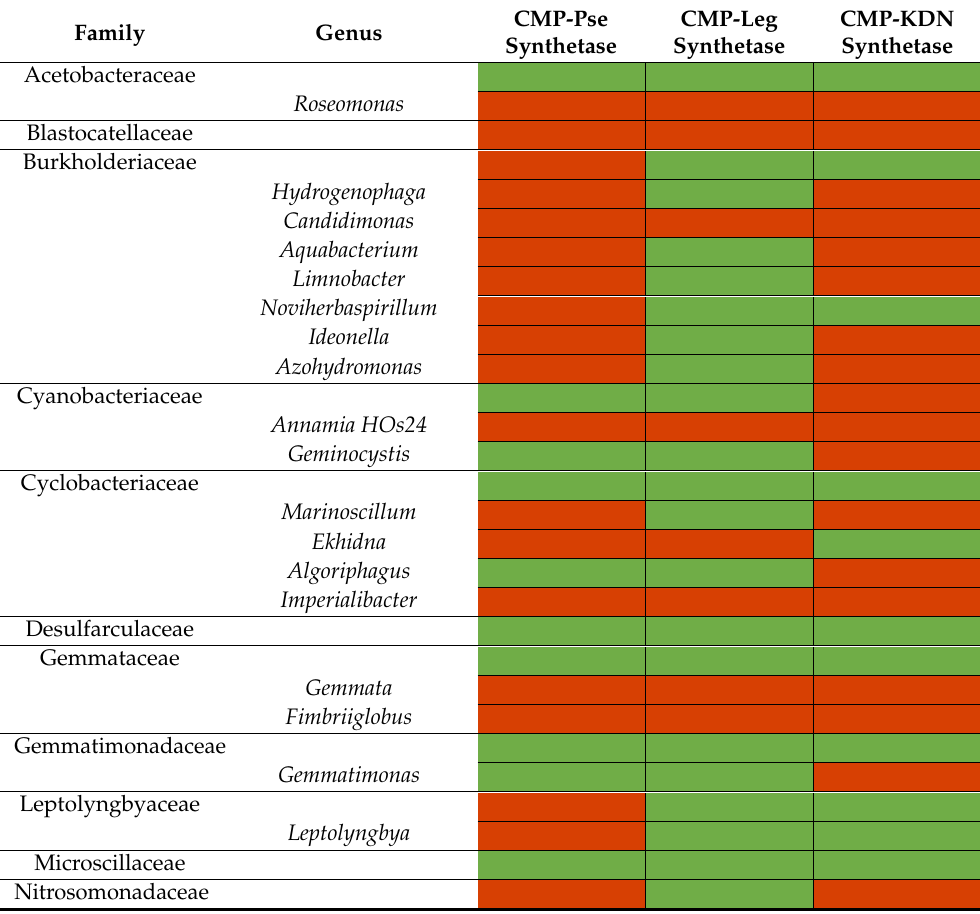
Table 1. Results of The Basic Local Alignment Search Tool (BLAST) analysis comparing the